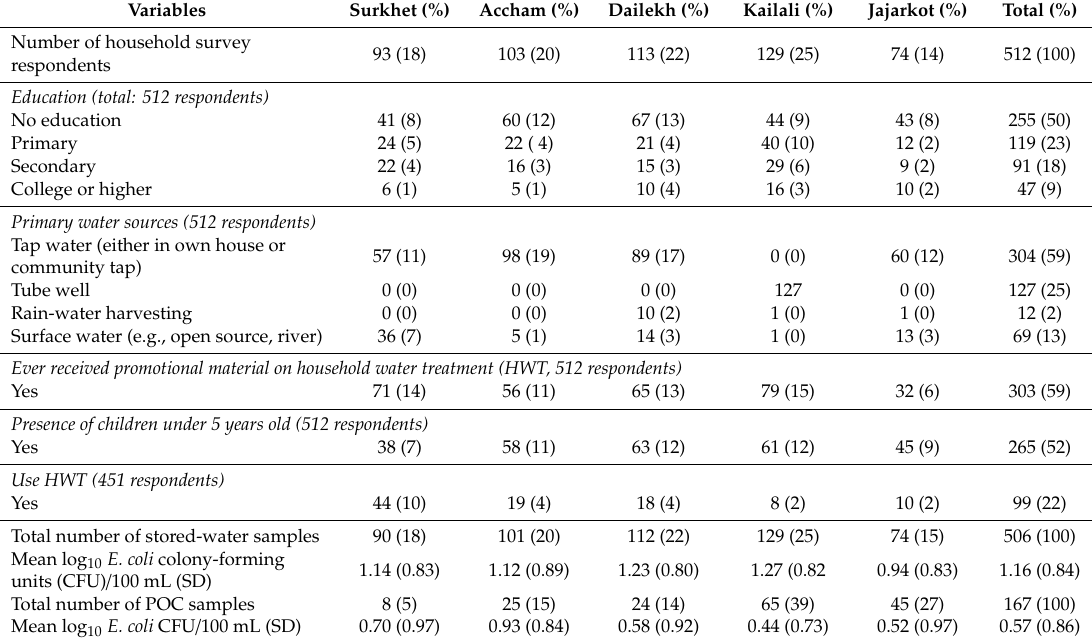
Figure 7. Typical water samples from Kailali (left) and the other four districts (right). Table 1. Household survey respondents’ characteristics, water sources and microbial